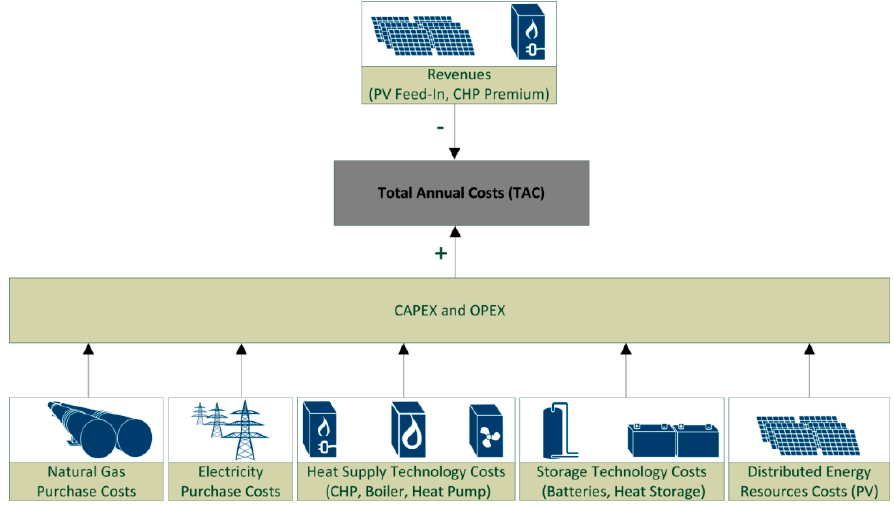
Figure 2. Composition of total annual costs in the microgrid optimization model.